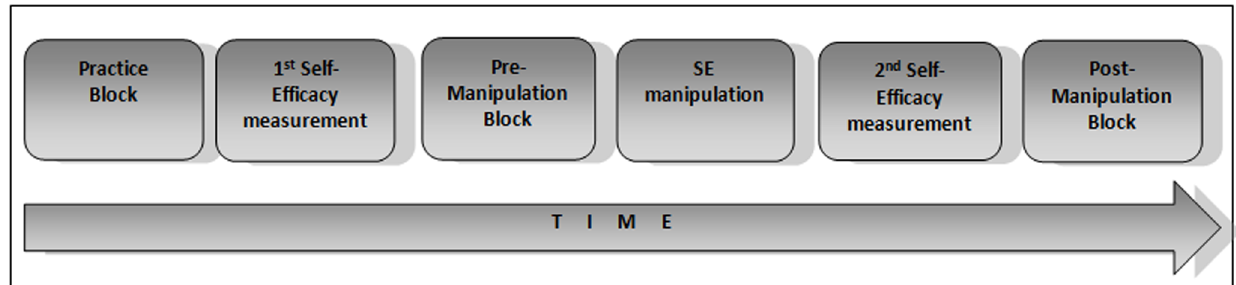
Figure 2. A schematic depiction of the experimental timeline as a function of time.